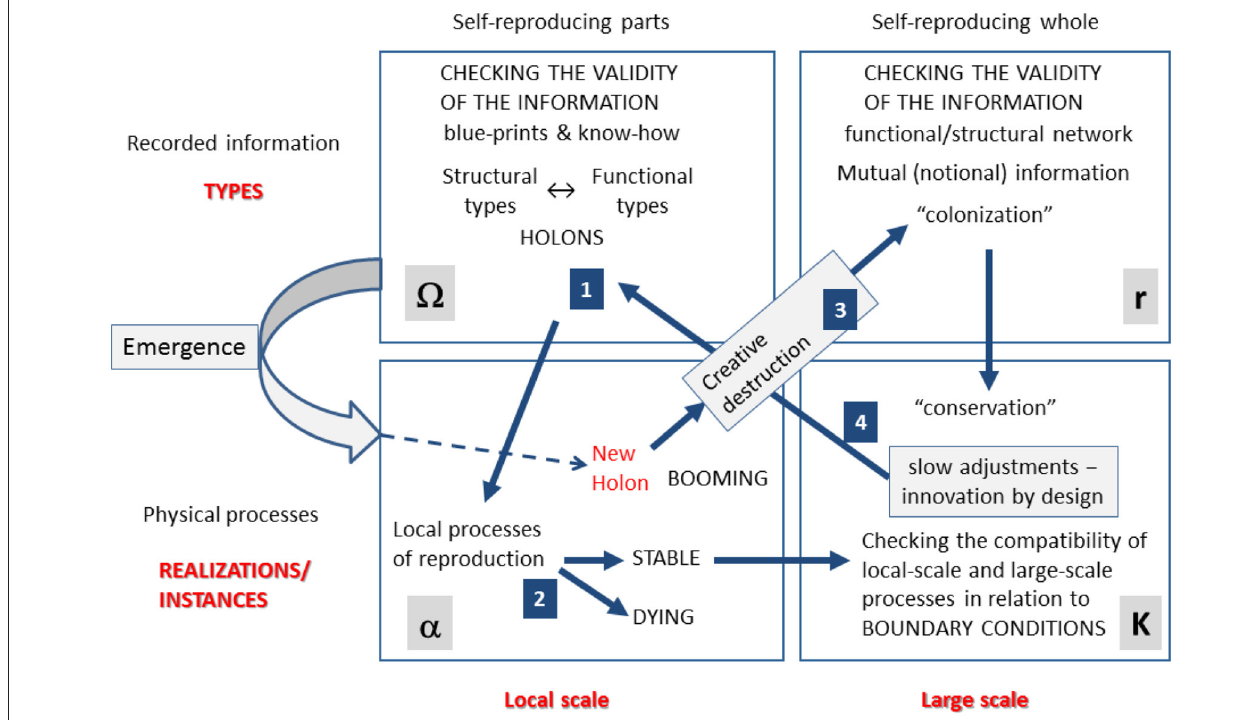
FIGURE 5 | The different roles of innovation in the adaptive